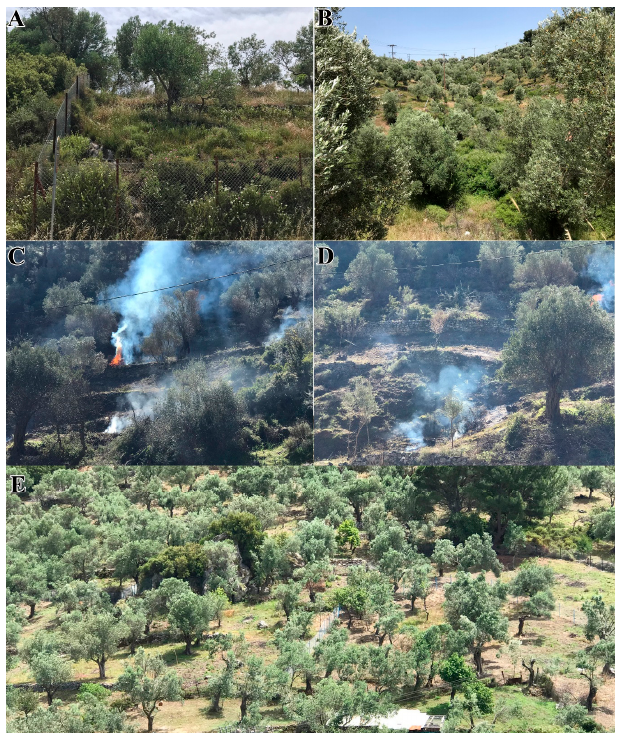
Figure A7. Pile burns of crown reduction residuals and shrubs, removed during the winter with mechanical means, in labor-intensive managed olive groves: ( A,B ) fuel conditions before the application of fuel removal and pile burning, with olive tree crowns in vertical continuity with tall shrubs, and understory where shorth dense shrubs mixed with tall grass prevail—fire behavior is represented with the fuel model GS1; ( C ) active combustion; ( D ) smoldering; ( E ) fuel conditions three months after the pile burns, where fuelbed consists of short grass and patchy short shrubs (photos by the authors).